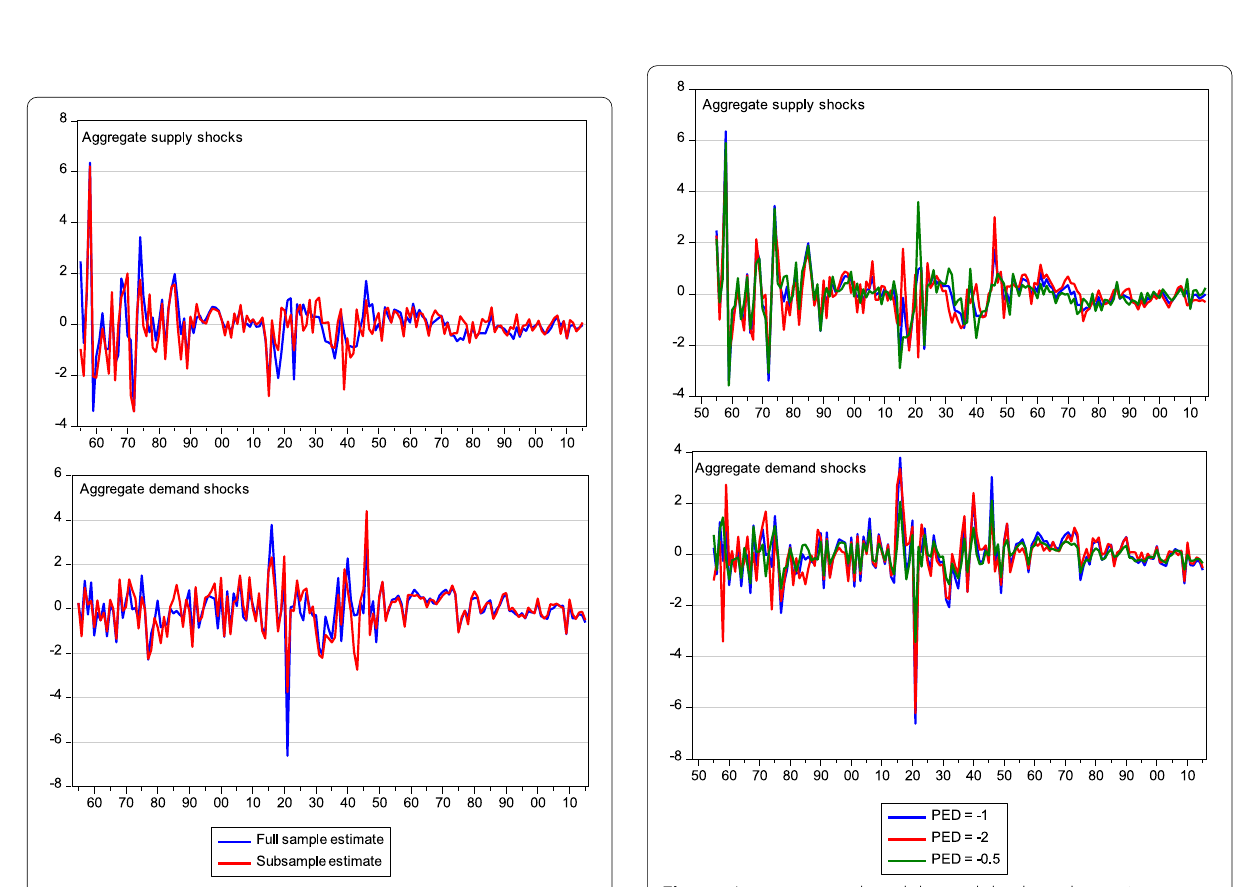
Fig. 10 Aggregate supply and demand shocks, subperiod and full sample estimates